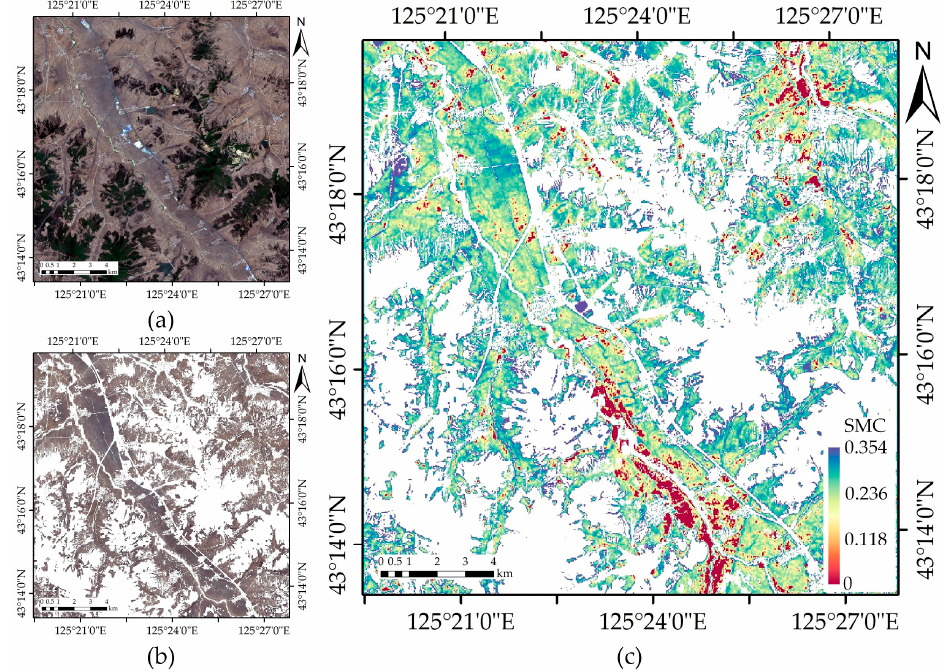
Figure 19. ( a ) Sentinel–2 MSI image of study area, satellite transit time: 2019–05–04; ( b ) Extraction of Figure 19. (a) Sentinel–2 MSI image of study area, satellite transit time: 2019–05–04; (b) Extraction of bare soil; ( c ) SMC map of study bare soil; (c) SMC map of study areas.